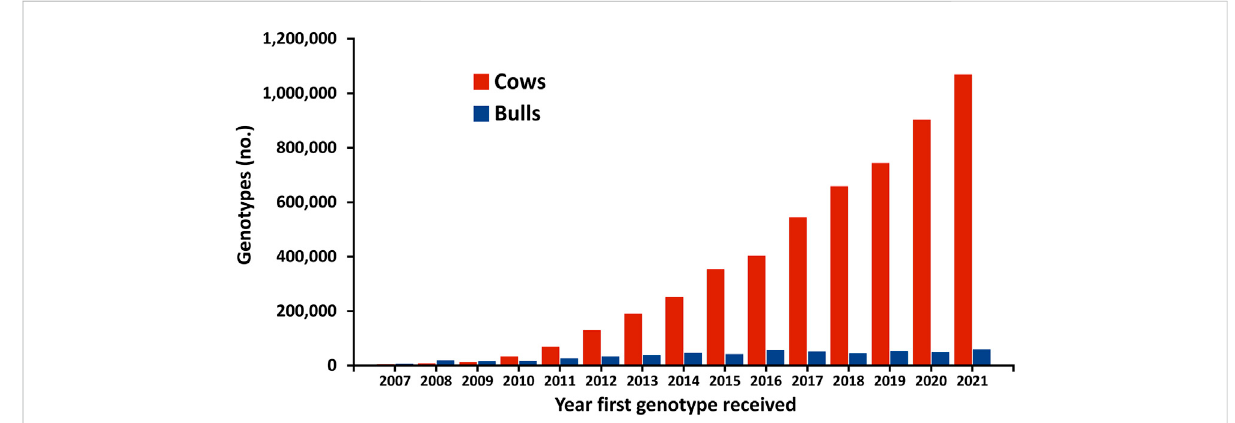
FIGURE 1 Number of dairy cattle genotypes submitted in the United States by year that fi rst genotype was